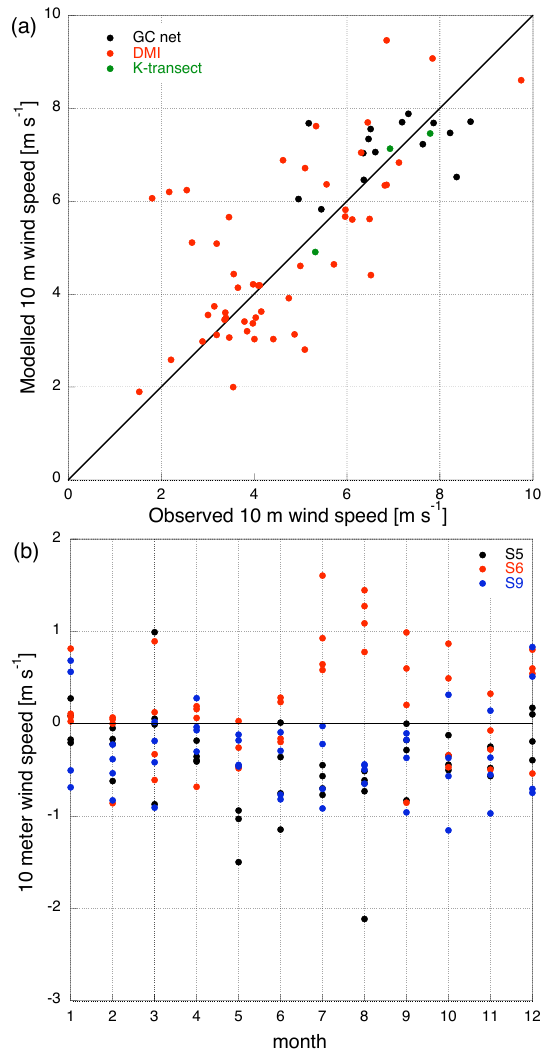
Fig. 7. Model performance for 10m wind speed [ms − 1 ]. (a) model versus observations for GC-net (black), DMI coastal stations (red), and K-transect (green), averaged over the available measuring pe- riod, (b) monthly model bias for S5 (black), S6 (red) and S9 (blue) over the period August 2003–August